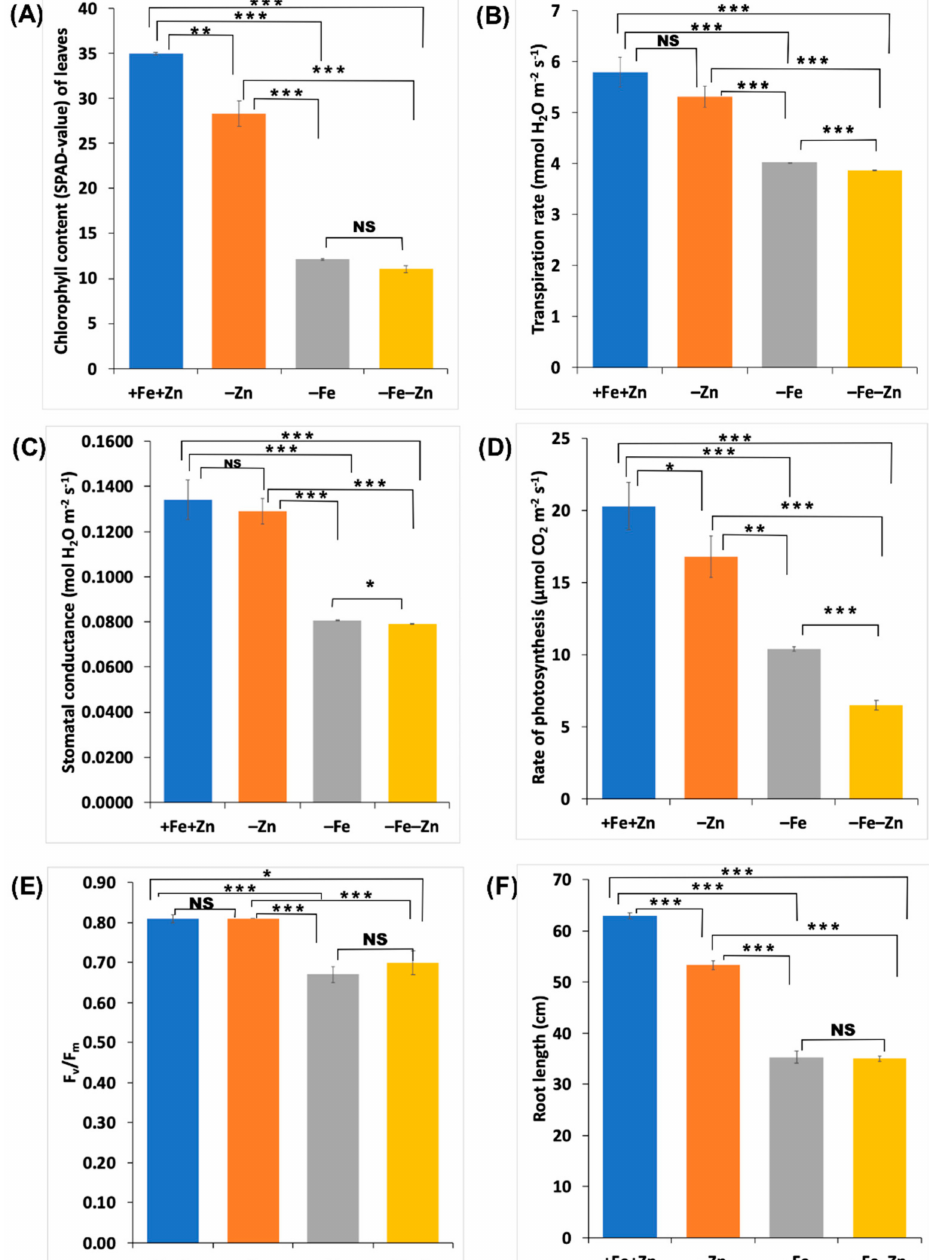
Figure 2. The morpho-physiological response of maize seedlings to –Zn, –Fe and –Fe–Zn deficiencies at 12 days after transplanting (DAT): ( A ) change in the chlorophyll content (soil plant analysis development (SPAD) value) of the leaves in response to the ( B ) transpiration rate; ( C ) stomatal conductance; ( D ) photosynthesis rate; ( E ) quantum e ffi ciency of PS II photochemistry (Fv / Fm); and ( F ) root length (*, **, *** significant at p < 0.05, p < 0.01 and p < 0.001, respectively; NS: